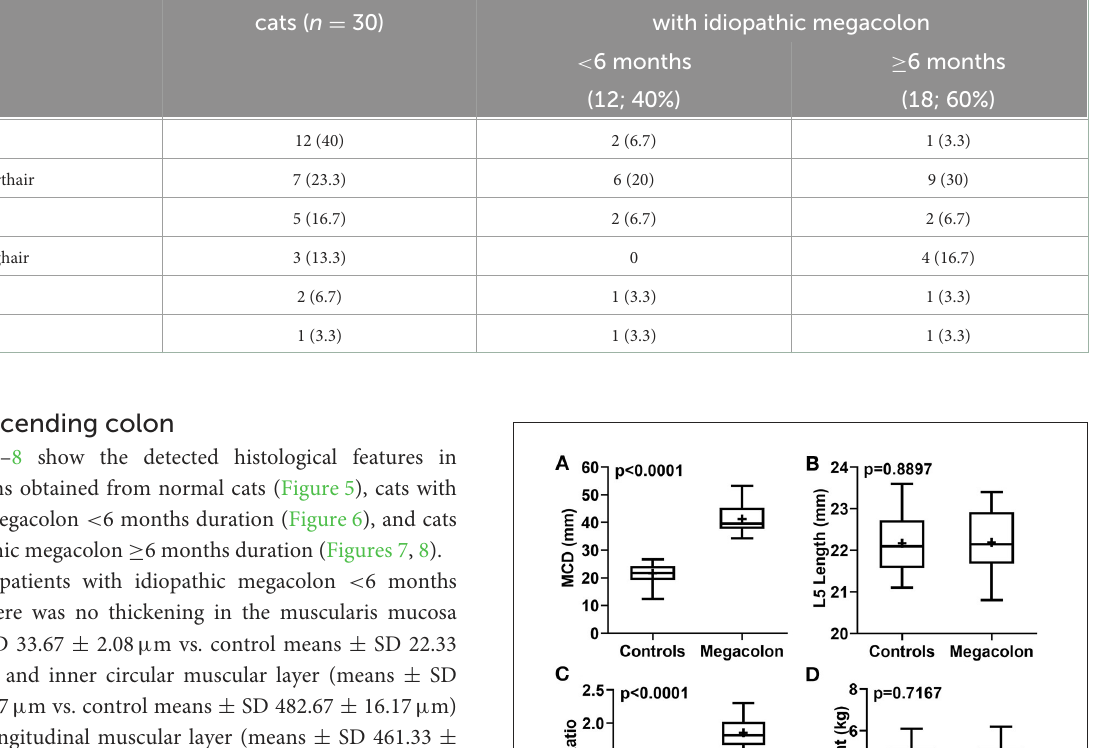
TABLE 1 Breed distributions of the cats that either was healthy without evidence of gastrointestinal disorders or had radiographically confirmed idiopathic megacolon and evaluated in this study. Breeds No. (%) of control No. (%) of cats cats ( n = 30) with idiopathic megacolon